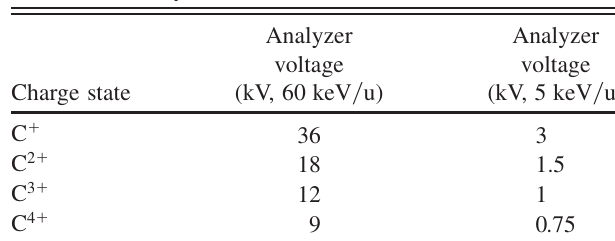
TABLE XIV. Transit condition of carbon ions in the electrostatic analyzer.